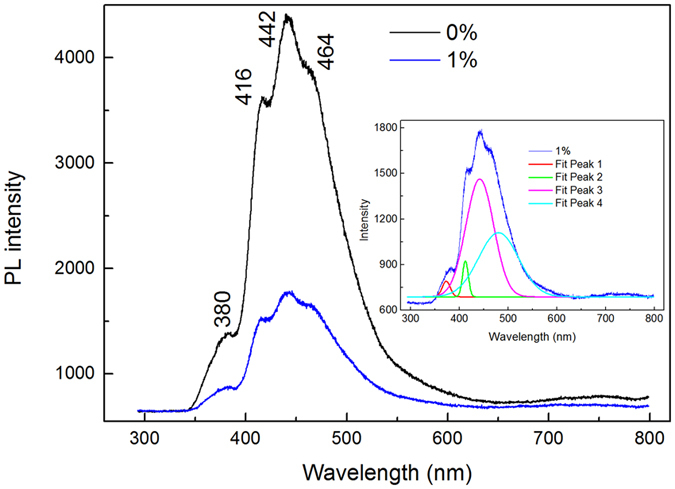
PL spectra of the β-Ga2O3 films deposited under different O2 volume percentage.